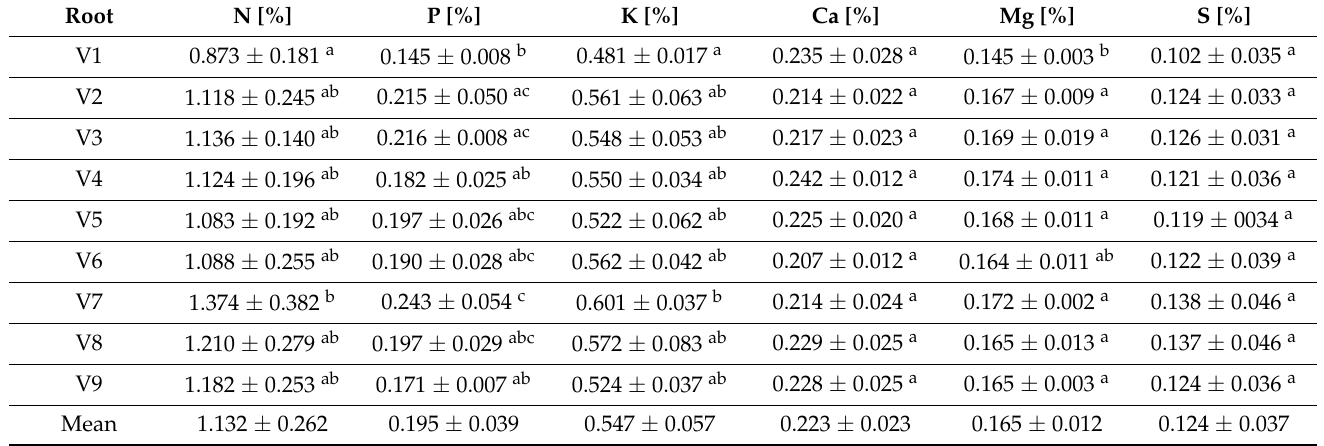
Table 6. Percentage of macroelements in the roots for each substrate density variant after growing the seedlings ( ± SD). The letters a, b and c indicate significant differences between the